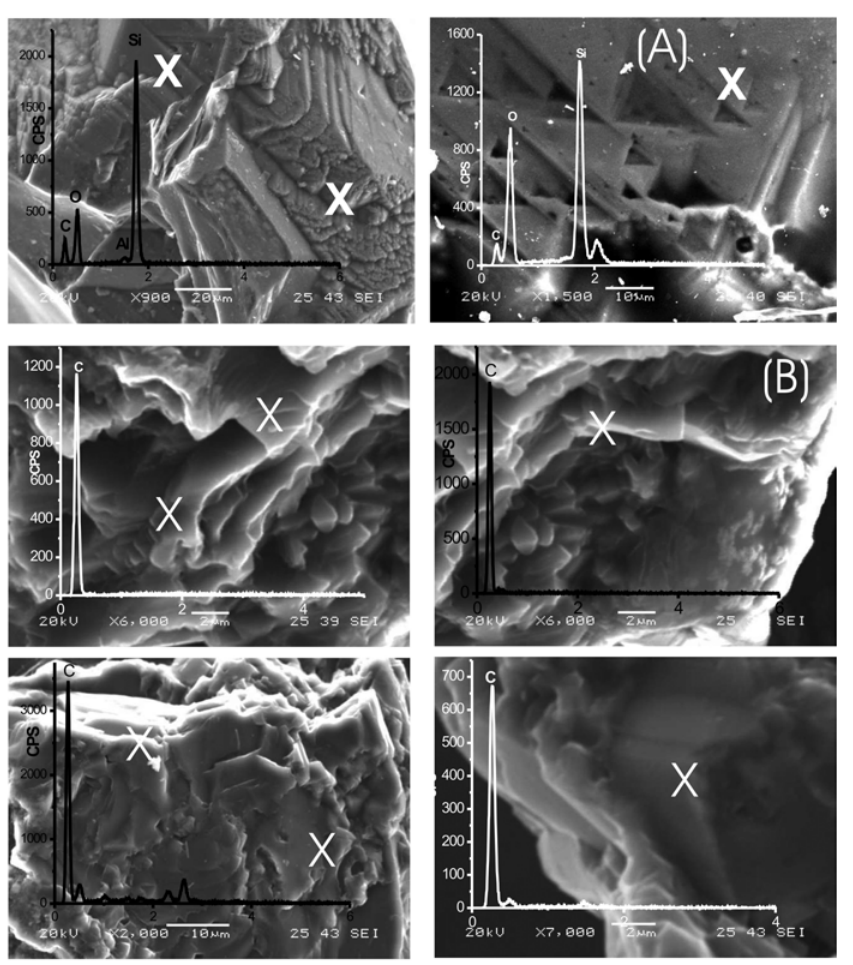
Fig. 5 – (A) SEM images and EDS spectrum of grains composed exclusively of SiO 2 with dissolution structures. (a) corrosion structures and negative trygons; (b) negative trygons. The trygons were originated by dissolution. X = analized points. (B) SEM images and EDS spectrum of grains composed exclusively of carbon identified in heavy mineral concentrates from the intrusive rocks. X = analized